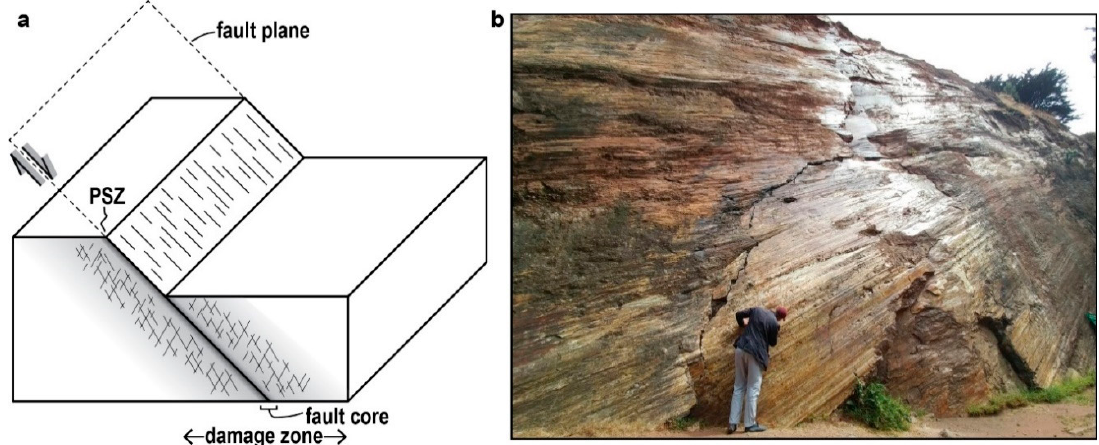
Figure 3. Principal slip zones (PSZs) in natural faults. ( a ) Sketch of a normal fault, highlighting the fault plane, damage zone, fault core, and PSZ (after [10,47]). ( b ). Striated, glossy surface of the Corona Heights Fault (USA) (courtesy of J. E. Samuelson).